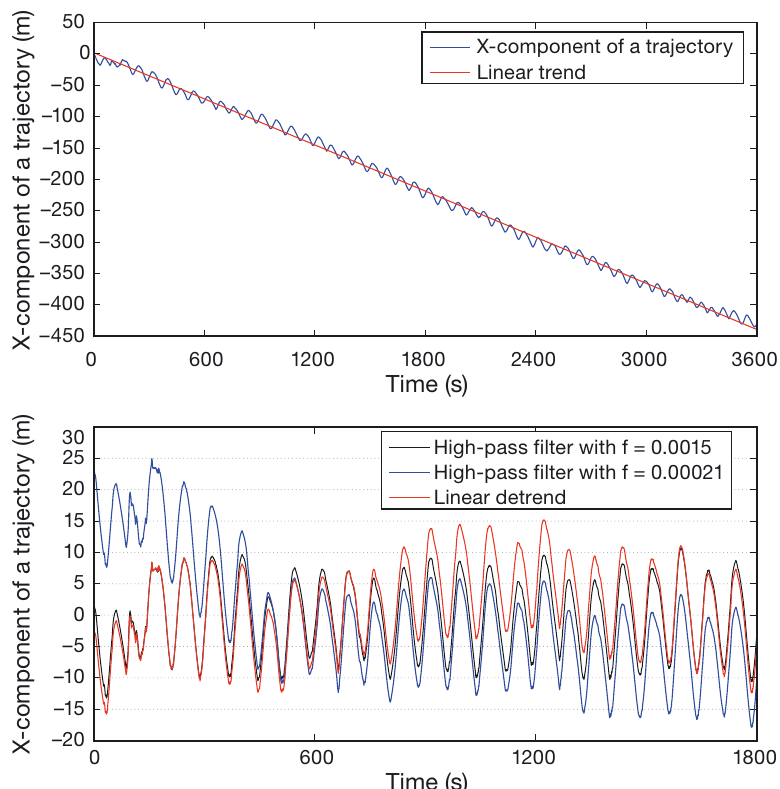
Fig. 3. (a) The liner trend in the x -component of the locomotion vector through time. (b) Corrected trajectories were calculated by subtracting a linear trend or using the designed high-pass filter. The maximum and minimum values are denoted by the red line (linear square regression method) and blue line (the high-pass filter with a cut-off frequency of 0.00021 Hz), respectively. The black line is the low-frequency (<0.0015 Hz) signal in the x -component of